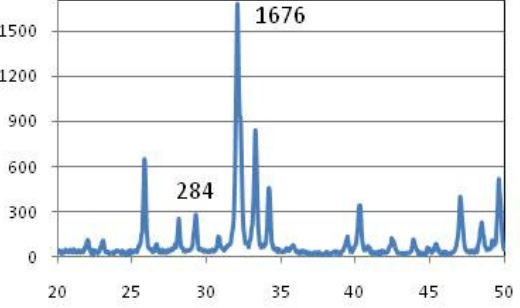
Fig. 2. XRD Spectra of beneficiated Akashat phosphate ore size 300 micron using lactic acid leaching.